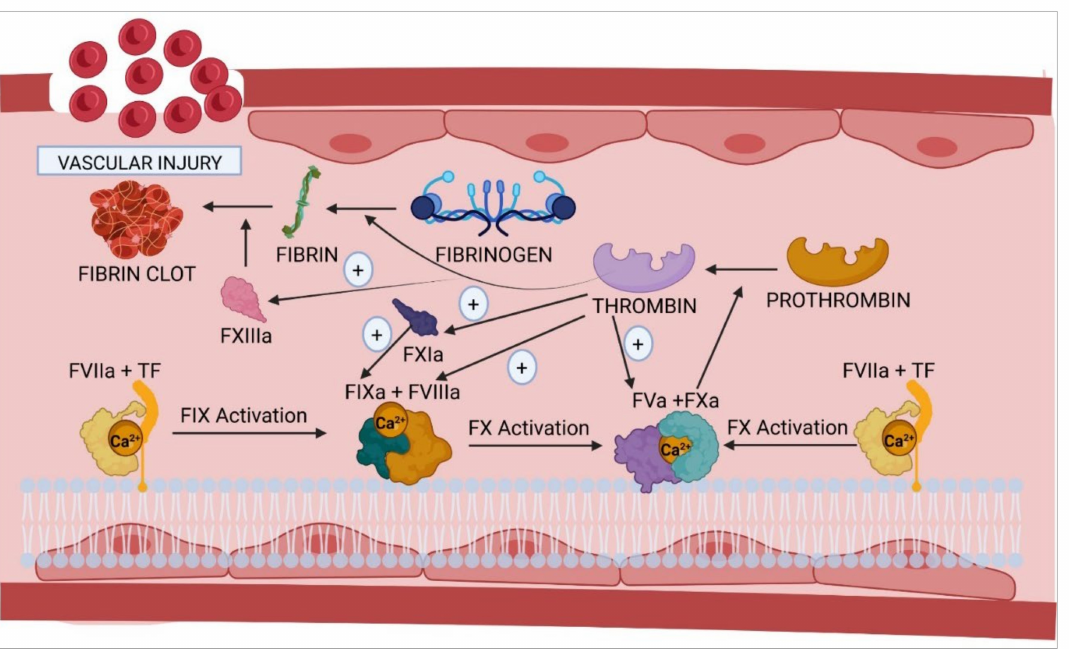
Figure 1. Activation of the coagulation cascade following vascular damage. The initiation complex, formed by the interaction of FVIIa and TF with the membrane phospholipids of the cells in the vascular endothelium, collaborates with calcium to activate FIX and FX to give rise, respectively, to the corre- sponding tenase and prothrombinase complexes. F, coagulation factor; TF, tissue factor; (+),